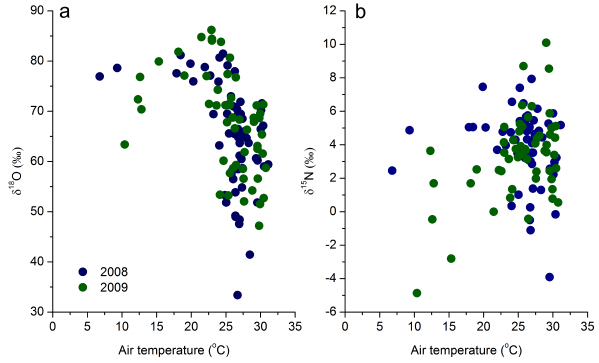
Fig. 4. δ 18 O-NO − (a) and δ 15 N-NO − (b) vs. mean air temperature 3 3 three days prior to sampling over the study period. For panel (a) , R 2 = − 0 . 21, P < 0 . 001 in 2008; and R 2 = − 0 . 20, P = 0 . 001 in 2009. For panel (b) , R 2 = − 0 . 03, P = 0 . 222 in 2008; and R 2 = 0 . 24, P < 0 . 001 in